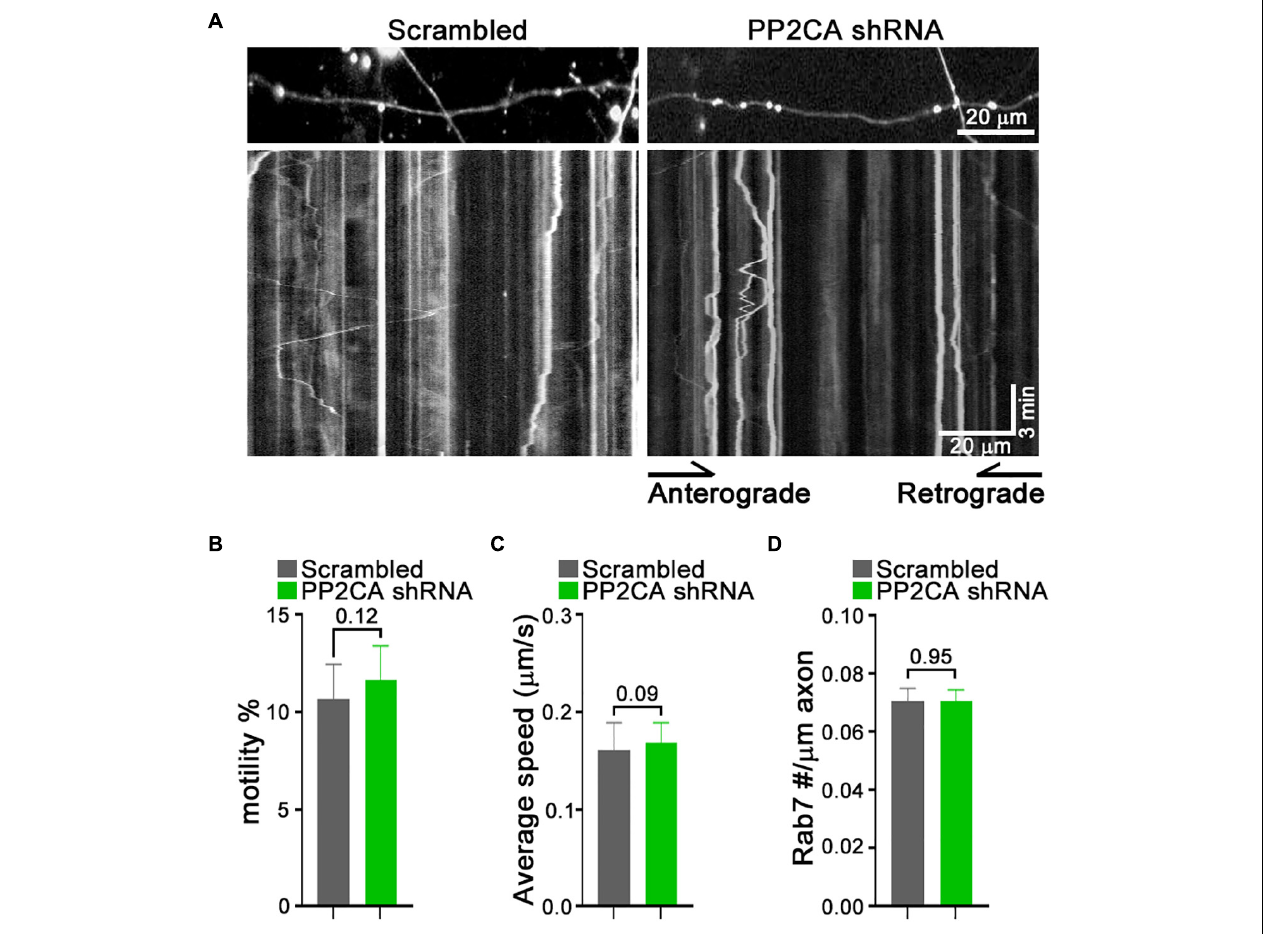
FIGURE 7 | Knockdown of PP2A catalytic subunit does not detectably alter rab7 transport. (A–D) Kymograph analysis of mCherry-Rab7-tagged late endosomes and lysosomes in neurons expressing a scrambled shRNA or PP2A shRNA. Representative kymograph images (A) and quantification of the percent of motile rab7-tagged organelles (B) , their average velocity (C) , and their density along the axons (D) . Statistical analysis was by nonparametric Mann–Whitney test (B,C) , and student t -test (D) . All experiments were done in three independent cultures. A total of 24 axon segments (177 mitochondria) for scrambled shRNA, and 25 axon segments (184 mitochondria) for PP2A shRNA neurons were analyzed. Each axon segment was selected from a separate neuron. Bars represent the average motility of all mitochondria analyzed for each condition. Error bars represent